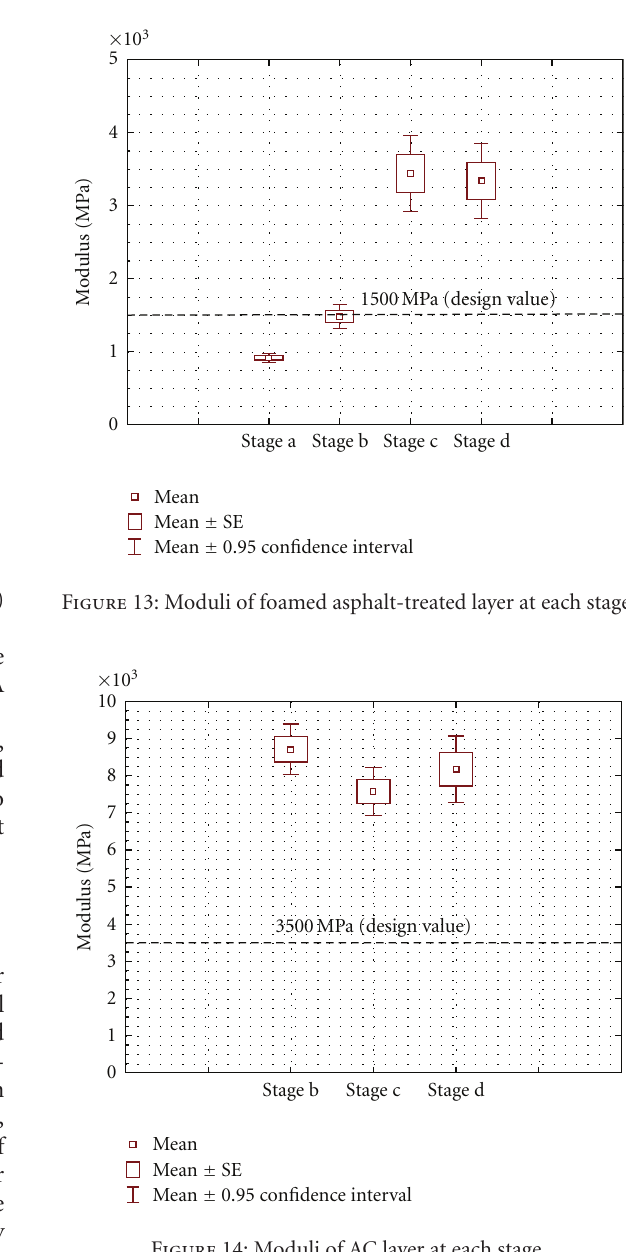
Figure 14: Moduli of AC layer at each